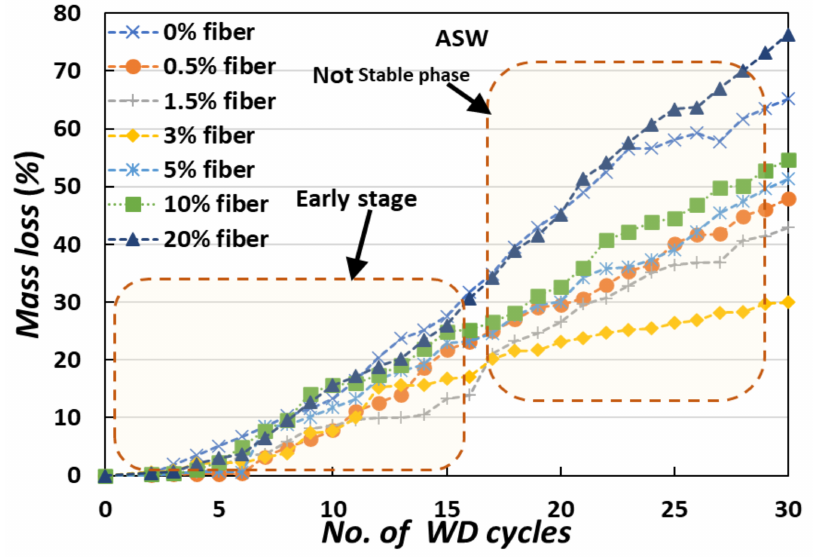
Figure 5. The average weight loss of the MICP-treated samples exposed to cyclic WD treatments (ASW